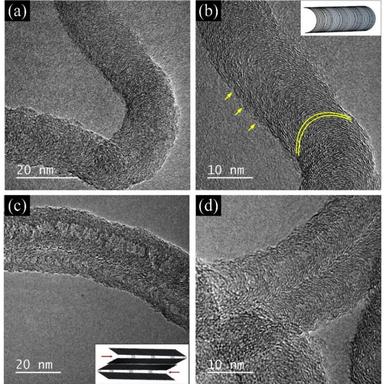
HRTEM images of carbon nanofibers from S5. (a) A continue stacking of short graphitic layers grown in one direction. Curved short graphitic layers stacking leading to the high border formation (yellow arrow) (b). (ced) Graphitic layers with a bamboo shaped-herringbone stacking.